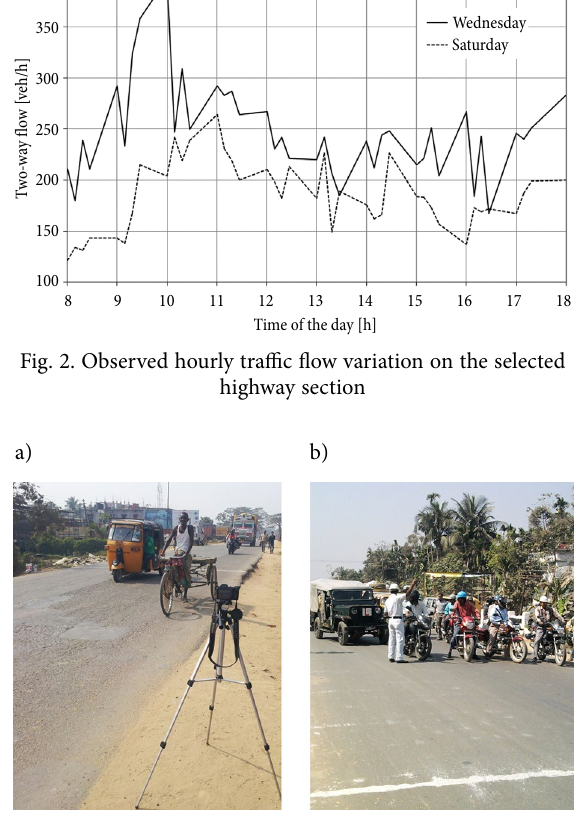
Fig. 3. A view of video photographic survey on the highway section equipped with road markings at: a –